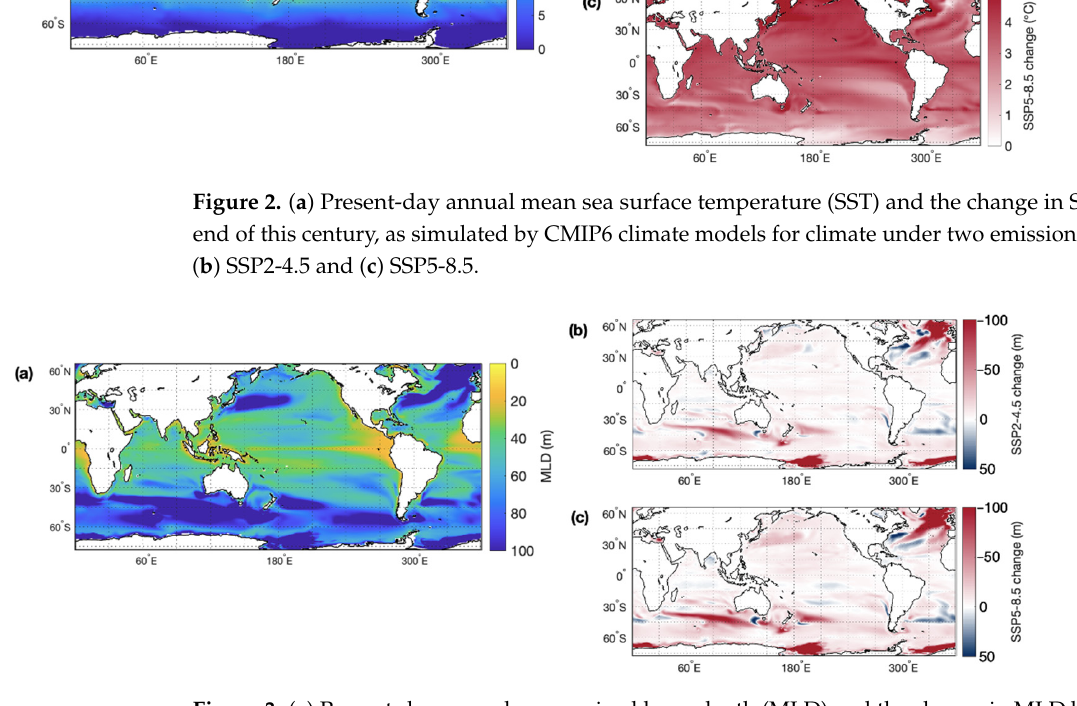
Figure 2. ( a ) Present ‐ day annual mean sea surface temperature (SST) and the change in SST by the end of this century, as simulated by CMIP6 climate models for climate under two emission scenar ‐ ios: ( b ) SSP2 ‐ 4.5 and ( c ) SSP5 ‐ 8.5.